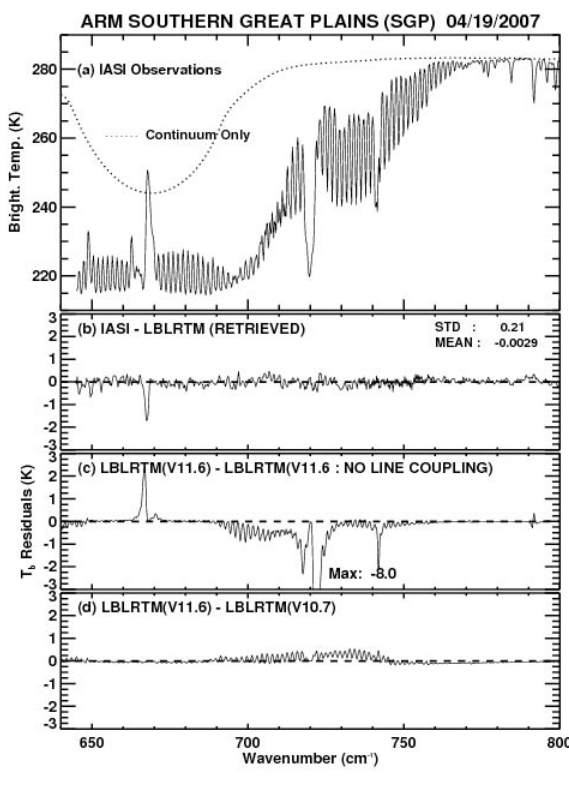
Fig. 15. (a) IASI brightness temperature spectrum in the CO 2 ν 2 region (640–800cm − 1 ) for the land case, showing the contribu- tion from the continuum. (b) IASI/LBLRTM final residuals. (c) Model/model brightness temperature differences: LBLRTM v11.6 (P, Q, and R line coupling, MT CKD v2.1 and chi=1) minus LBLRTM V11.6 (no line coupling, MT CKD v2.1, and chi=1). (d) Model/model brightness temperature differences: LBLRTM v11.6 (P, Q, and R line coupling, MT CKD v2.1 and chi=1) minus LBLRTM v10.7 (with old Q-branch line coupling, old continuum and the older chi